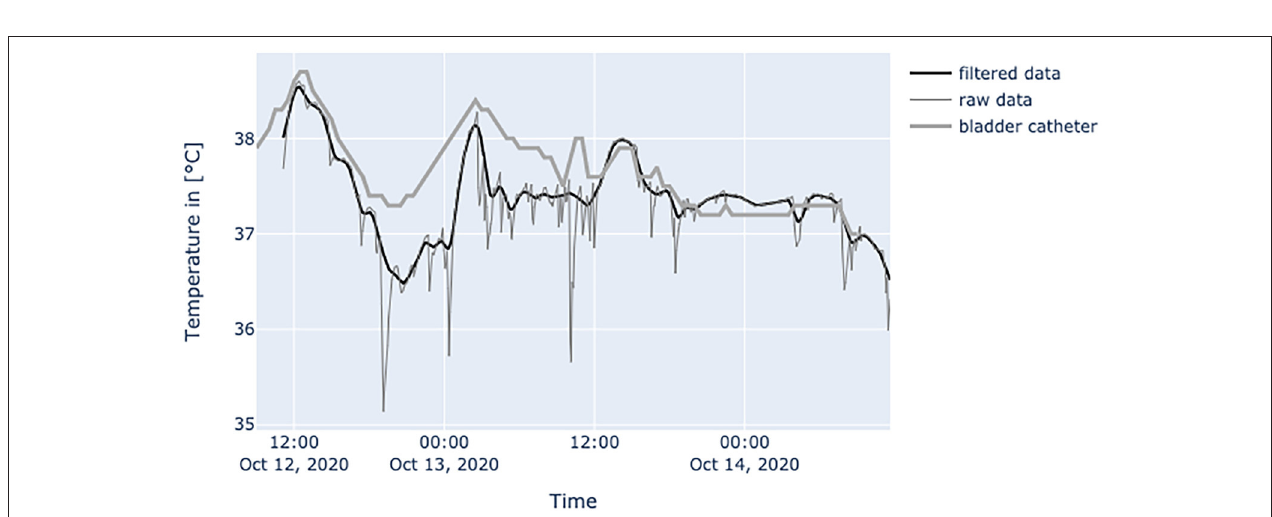
FIGURE 8 | Diagram shows temperature values of a septic patient, who received 1g acetaminophen and 1g metamizole on Oct.12, 2020 at 1 p.m. When temperature falls, the effects on the peripheral site are much more severe and can be seen over a prolonged period of time. Raw temperature values nearly reaching 35 ◦